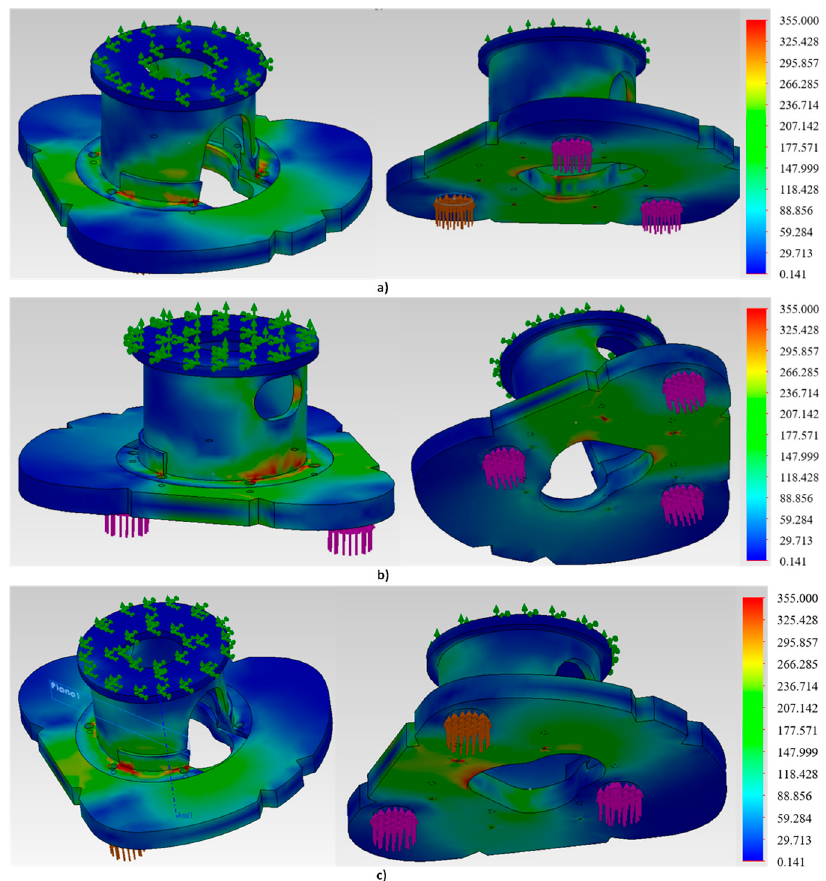
Figure 18. Finite Elements Model adopted to design the tripod: stress-field (N/mm 2 ) according to the Von Mises criterion, for ( a ) static loading combination a, and for seismic loading combination ( b ) b 1 , and ( c ) b 2 .